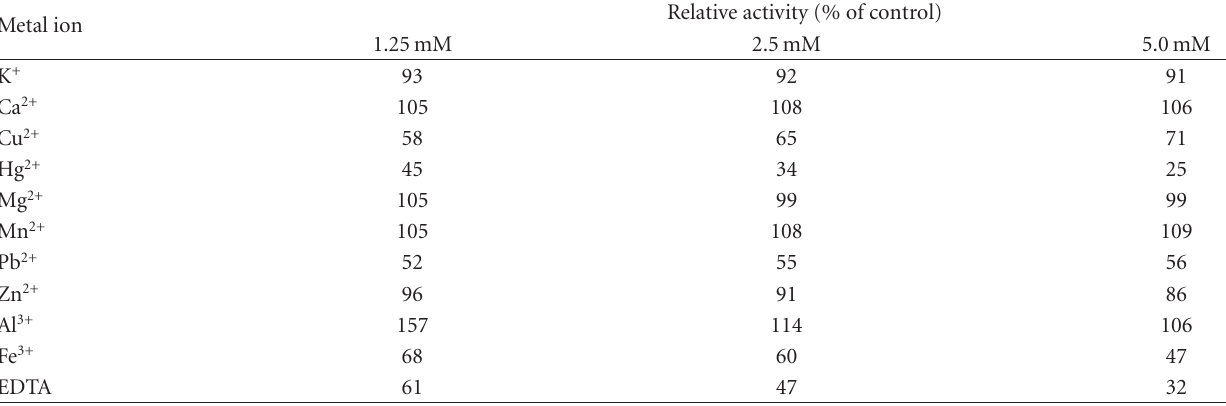
Table 3: E ff ect of metals and chemical reagents on the activity of A. placomyces laccase.